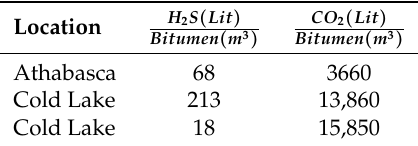
Table 2. Average volume of CO 2 and H 2 S produced per m 3 of bitumen at 240 ◦ C. These data were extracted from core analysis